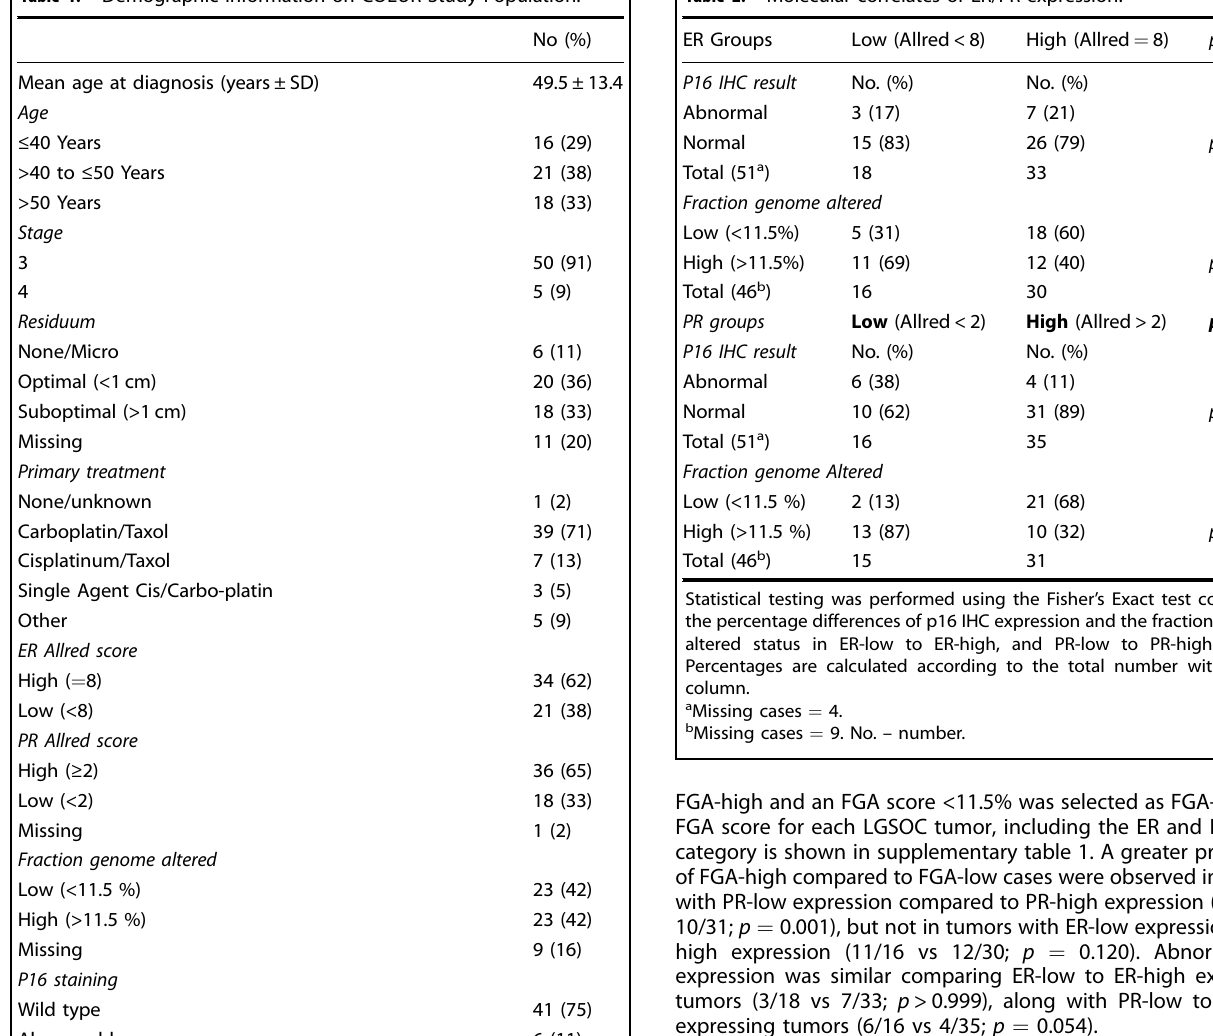
Table 1. Demographic Information on COEUR Study Population. Table 2. Molecular correlates of ER/PR